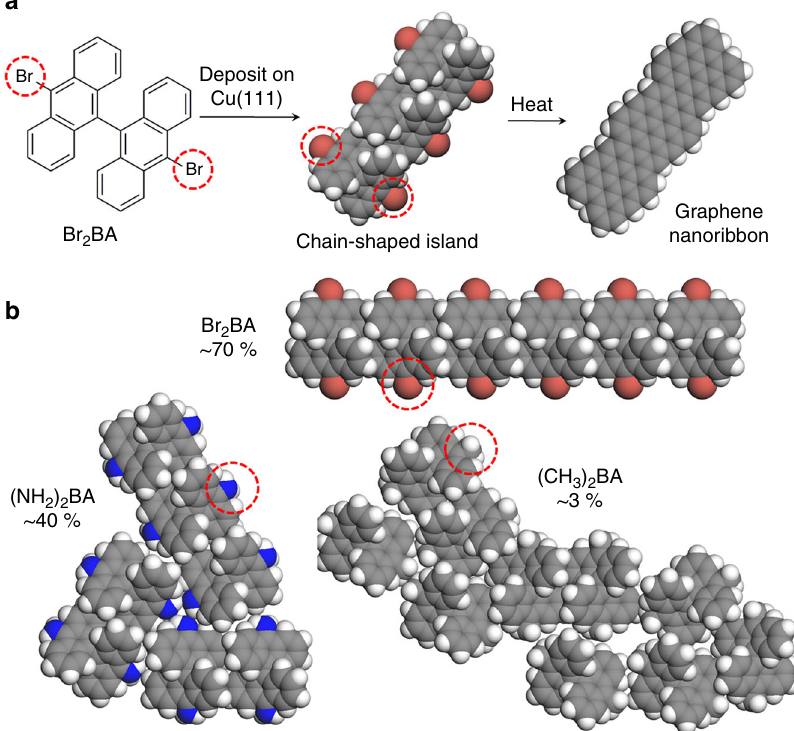
Fig. 1 Self-assembly of bianthracene precursors on copper(111). a Bottom-up fabrication of graphene nanoribbons via deposition of dibromo-biranthracene (Br 2 BA) on a copper 111 (Cu(111)) surface. The molecules form chain-shaped ‘ islands ’ via self-assembly, which undergo a chemical reaction to form graphene nanoribbons upon heating 5 . The Cu(111) surface is in the plane of the page, but not shown explicitly. Bromine functional groups are indicated by the red circles. b Some typical islands formed at 200 K by various bianthracene molecules possessing different functional groups (as predicted by the GAMMA model 11 ). The percentages are probabilities of forming isolated chain-shaped islands. Functional groups are indicated by the red circles. Gray spheres = carbon, white spheres = hydrogen, red – brown spheres = bromine, and blue spheres = nitrogen atoms. All molecule structures were drawn